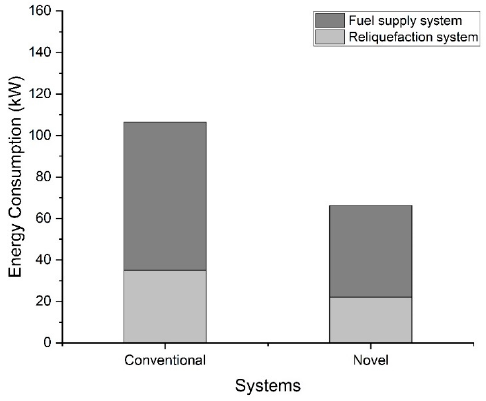
Figure 6. Energy consumption for conventional and novel re-liquefaction and fuel supply systems in LPG